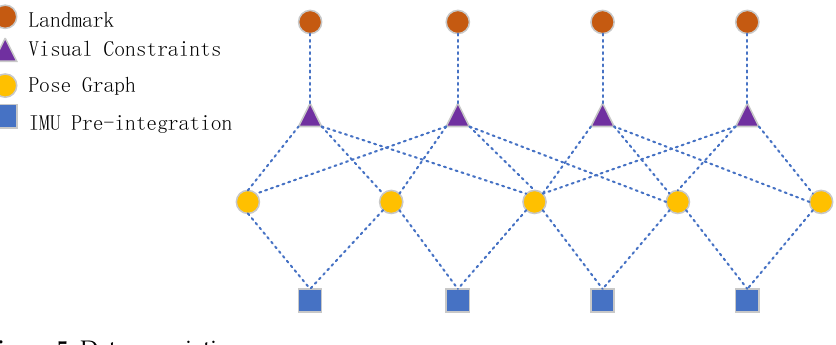
Figure 5. Data association.